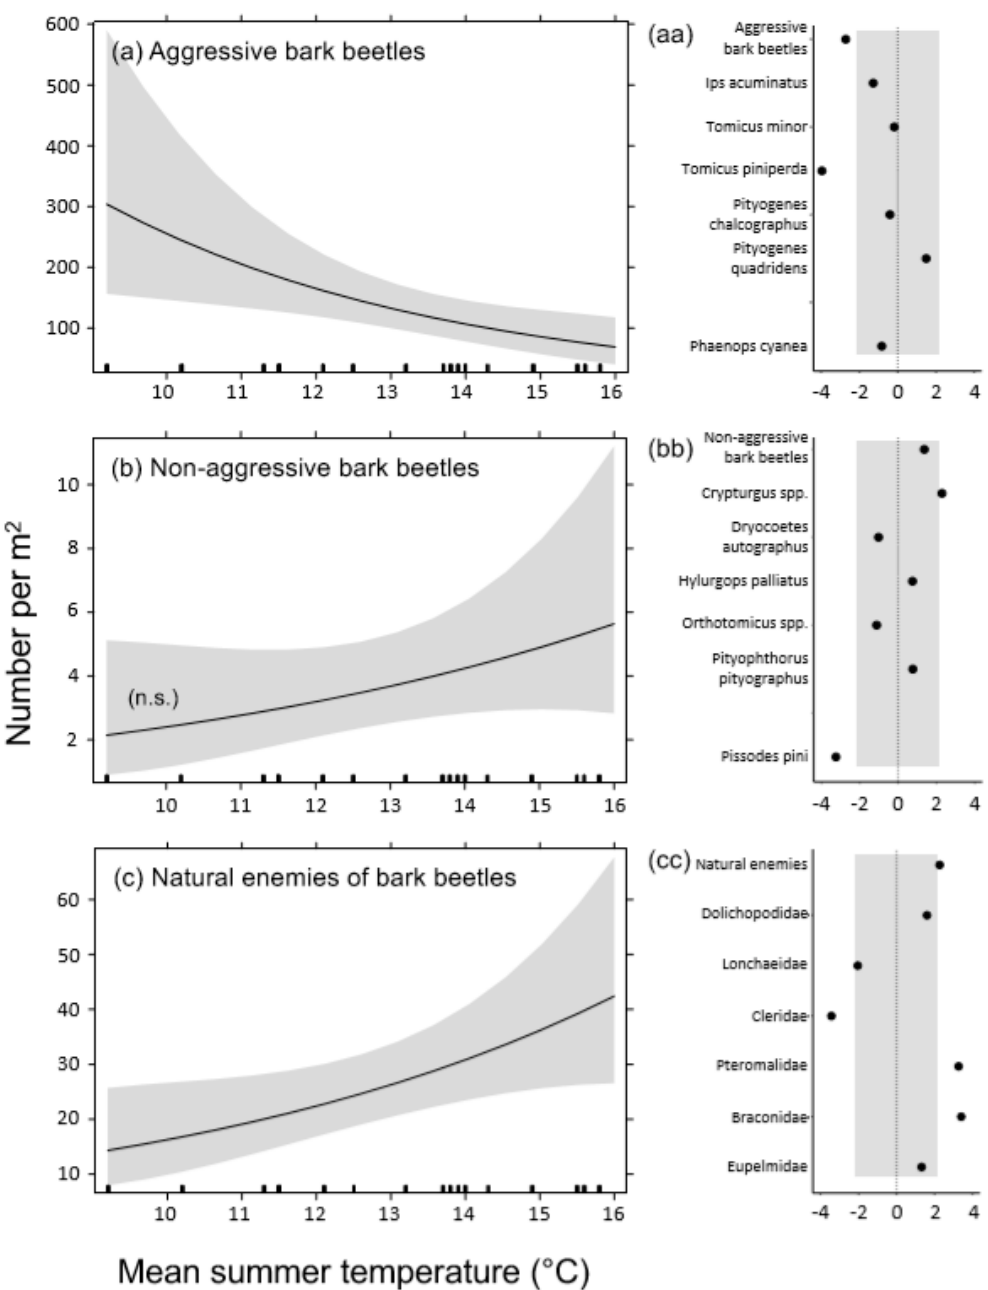
Figure 1. Relationships between mean summer temperatures and densities of ( a ) aggressive bark beetles and the buprestid P. cyanea , ( b ) non-aggressive bark beetles and the weevil P. pini , and ( c ) and natural enemies of bark beetles at different elevations as well as t -values ( aa – cc ). Negative t -values indicate negative association with temperature, and vice versa; the shaded areas indicate the 95% confidence bands ( a – c ) and the non-significant range ( aa – cc ) ( p ≥ 0.05). The rug plots at the bottom of the graphs show the values measured in this study. Statistical details are given in Table